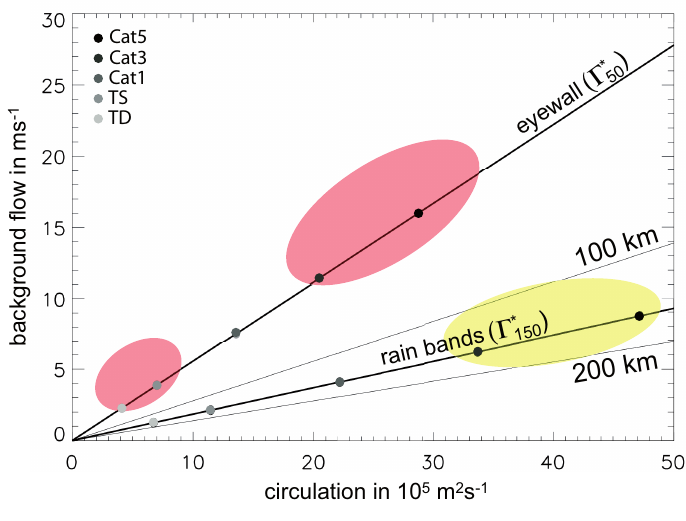
Figure 8. Regime diagram for the environmental interaction of TCs in vertical wind shear. The sloping lines denote the closest radius of the dividing streamline for a combination of circulation (abscissa) and storm-relative flow (ordinate). For eyewall interaction the TC categories are defined by Γ 50 , for rain band interaction Γ 150 is used (see Sec. 3.2.1). The TC categories are highlighted by the shaded dots. The red shading indicates the regime of eyewall interaction for weak and mature TCs (as defined in table 1), respectively. Yellow shading indicates the regime of rain band interaction for mature TCs. The eyewall radius (50 km), 100 km radius, the rain band radius (150 km), and 200 km radius are depicted (from top to bottom).